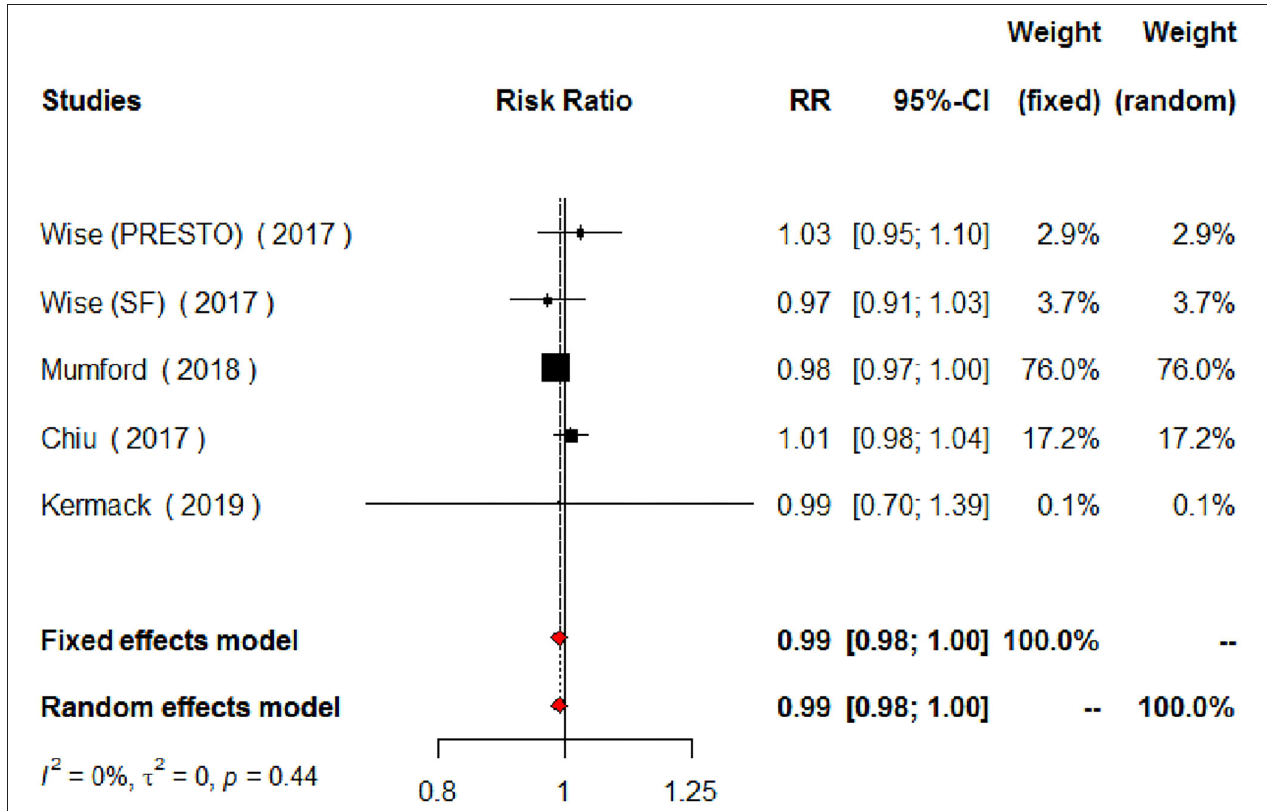
FIGURE 2 | Forest plot for the meta-analysis of the relationship between periconceptional intake of PUFAs and pregnancy achievement ( n =